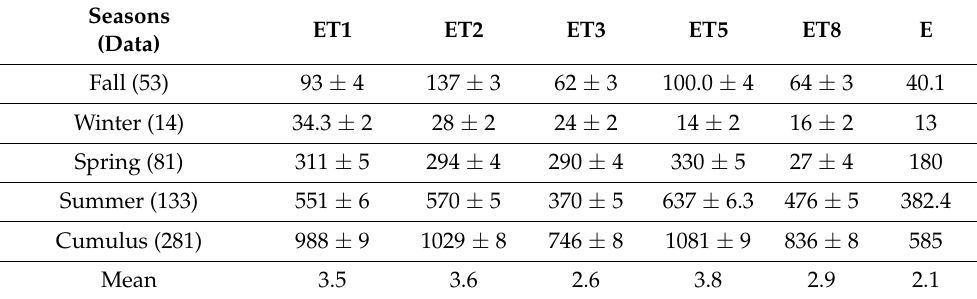
Table 7. Comparative totals and averages (in mm) of evaporation (E) and evapotranspiration (ET) estimated, respectively, with the evaporimeter and the lysimeters (data =